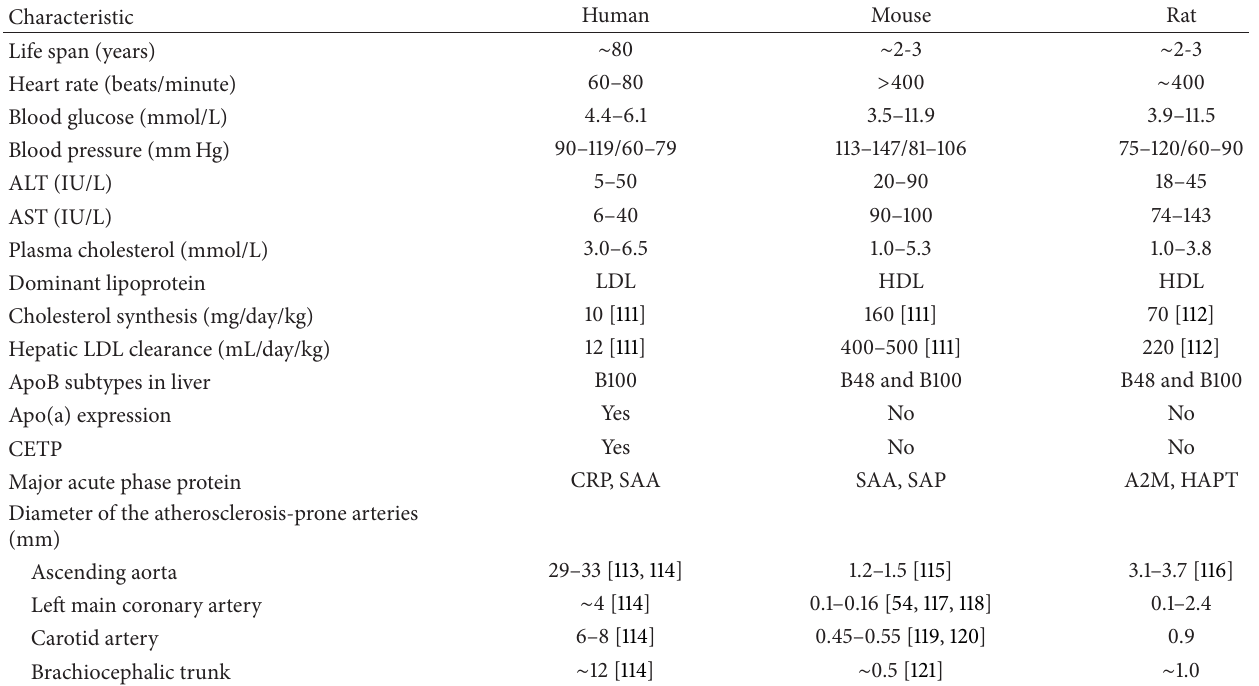
Table 1: Physiological differences between human, mouse, and rat relevant for the study of diabetic vascular complications. Characteristic